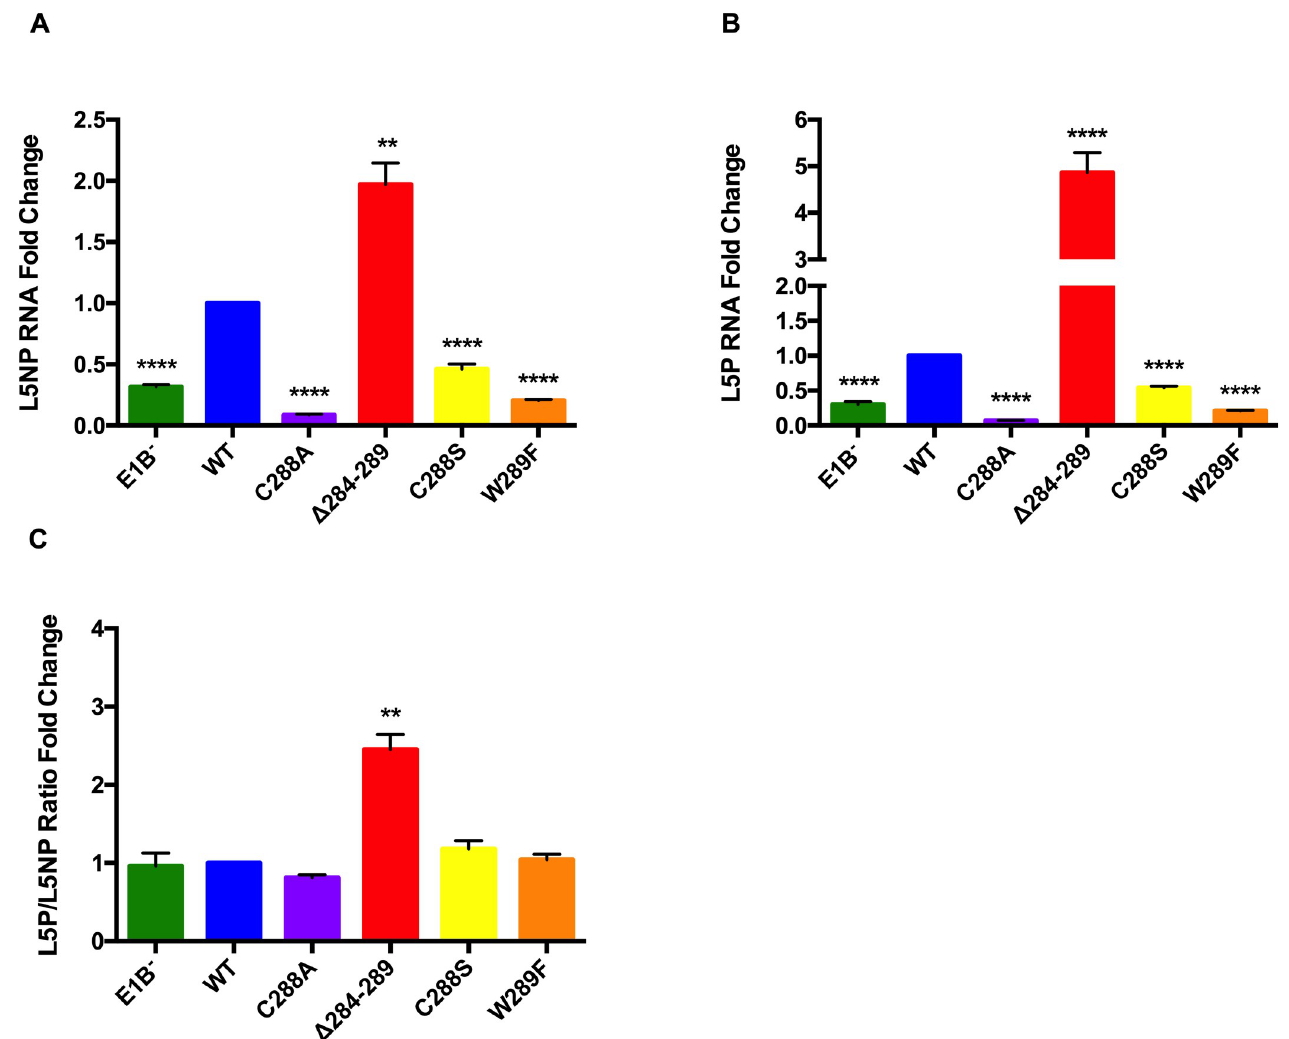
Fig 8. Substitutions in E1B 55K RNP affect viral late mRNA biogenesis. HFF cells infected with Ad5 WT or E1B 55K mutants were harvested at 36 hpi and total RNA was isolated. Viral late pre-mRNA levels were determined for L5 RNA by RT qPCR against an (A) intron-exon (L5NP) or (B) Exon-exon (L5P) junction, for the unspliced and spliced L5 mRNA species, respectively. (C) To compare the splicing efficiency the L5P:L5NP ratios were calculated. β actin mRNA was used as endogenous control. Data from two independent experiments performed in triplicate are shown. �� P < 0.01, ���� P < 0.0001.